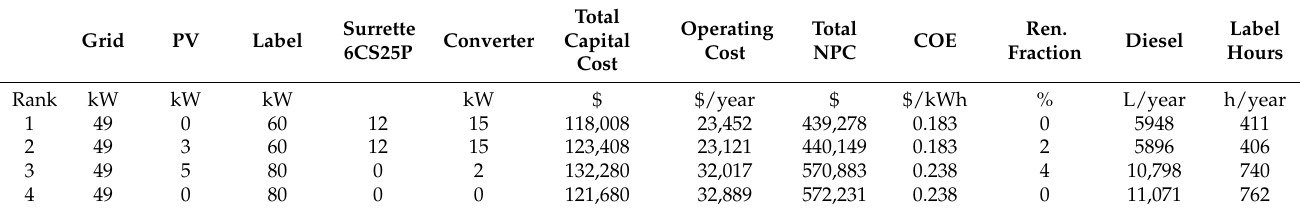
Table 2. Optimized On-grid hybrid energy systems as a measure of the lowest